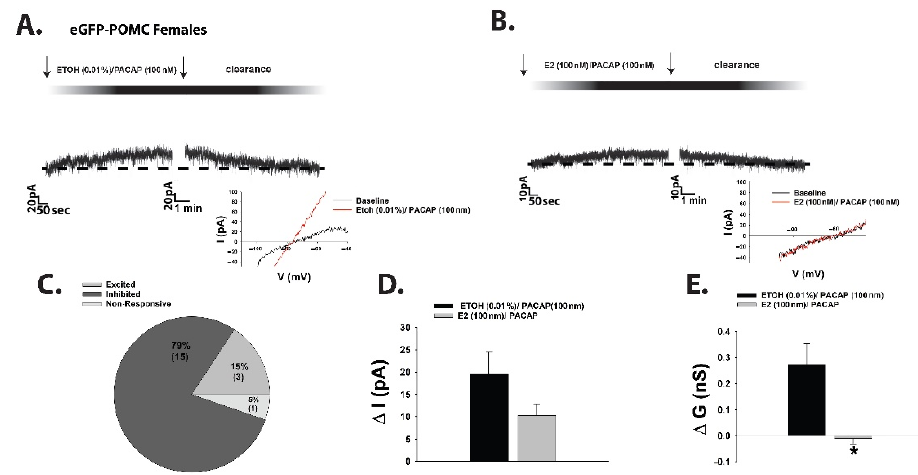
Figure 3. E 2 attenuates the PACAP-induced outward current in POMC neurons observed under fasting conditions. ( A , B ) are representative membrane current traces during voltage clamp recordings in EtOH vehicle- (0.01% ( v:v ); n = 11) and E 2 -treated (100 nM; n = 8) slices from OVX females that illustrate the estrogenic diminution of the robust and reversible PACAP-induced outward current and change in K + conductance (as seen from the inset I/V plots). ( C ), Pie chart that indicates the percentage of POMC neurons from OVX females that are excited by, inhibited by, or unresponsive to PACAP under fasting conditions. ( D , E ) show the composite data underscoring the ability of E 2 to negatively modulate the PACAP response. Bars represent means and lines 1 SEM of the PACAP-induced ∆ I and ∆ G in POMC neurons from OVX females under fasting conditions. *, p < 0.05 relative to EtOH vehicle, Student’s t